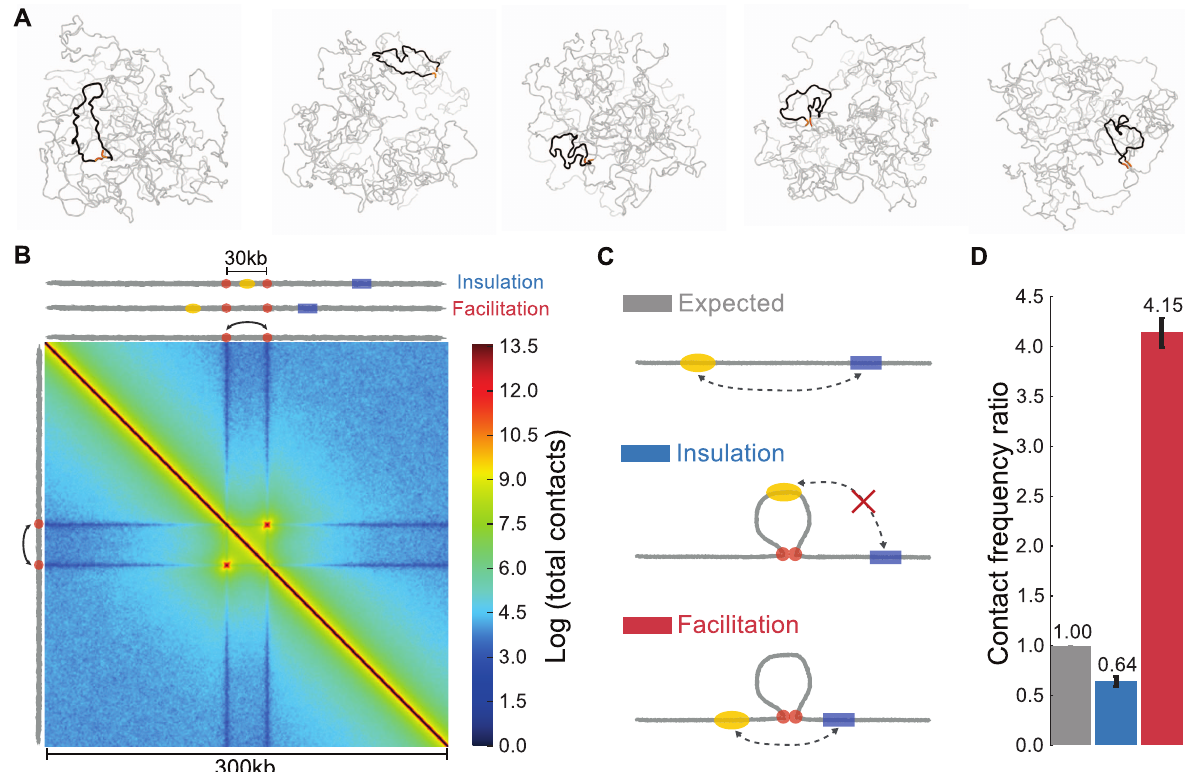
Figure 2. A chromatin loop alters the frequency of enhancer-promoter interactions. ( A ) Five sample conformations from polymer simulations with a 30 kb permanent loop (black) formed between two loop bases (orange) in a 1 Mb region of fiber. ( B ) Average heatmap (300 kb by 300 kb) for polymer simulations of the permanent, one-loop system, with a 30 kb loop (aggregated over 800,000 simulated conformations). Top and left edges show positions of the enhancer (yellow), promoter (blue), and loop bases (orange) for insulation and facilitation arrangements. ( C ) Schematics of E-P arrangements. ( top ) chromatin fiber without a fixed loop and with E-P genomic distance of 50 kb, as used to calculate expected (no-loop) contact frequencies (Methods). ( middle ) arrangement where insulation is observed, represented by the red ‘‘X’’. ( bottom ) arrangement where facilitation is observed. ( D ) Contact frequency ratios (Methods) for insulation and facilitation arrangements with a 30 kb loop and 50 kb E-P genomic distance. Here and below, error bars indicate one standard deviation about the mean.